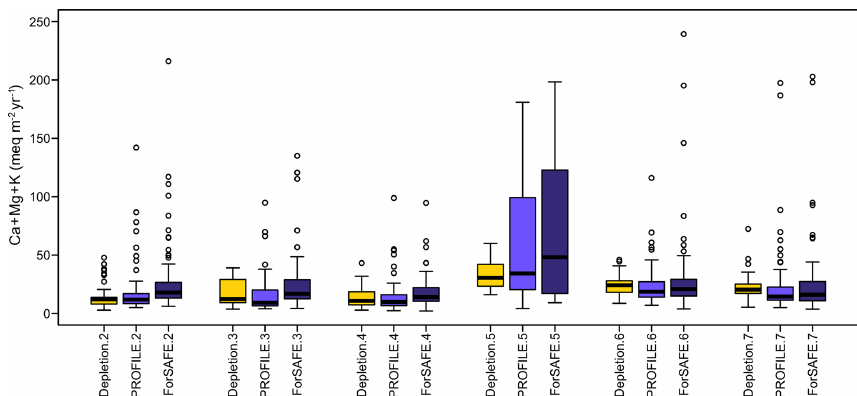
Figure 5. Box plots for the three methods and for the climate regions: (2) inner part of northern Sweden, (3) coastal part of northern Sweden, (4) western part of central Sweden, (5) eastern part of central Sweden, (6) southwestern Sweden, and (7) southeastern Sweden. The Northwestern mountain region (1) was excluded since it only contained one site.